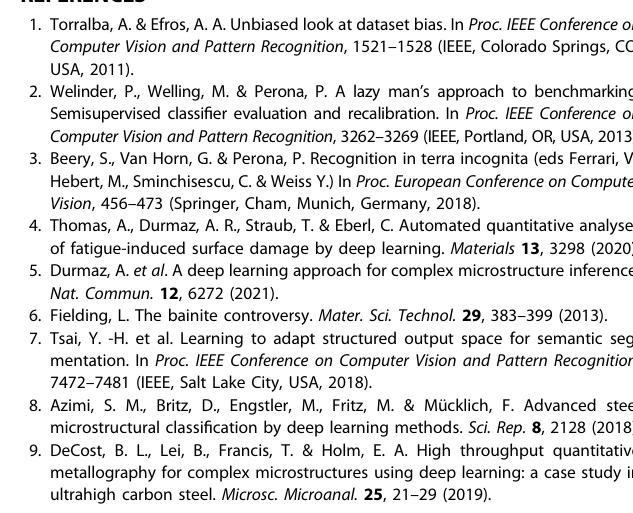
Table 2. Data augmentation was applied to train all our models except for the NanoSEM pre-training. In the UDA framework, both source and target datasets were augmented using the optimized pipeline.